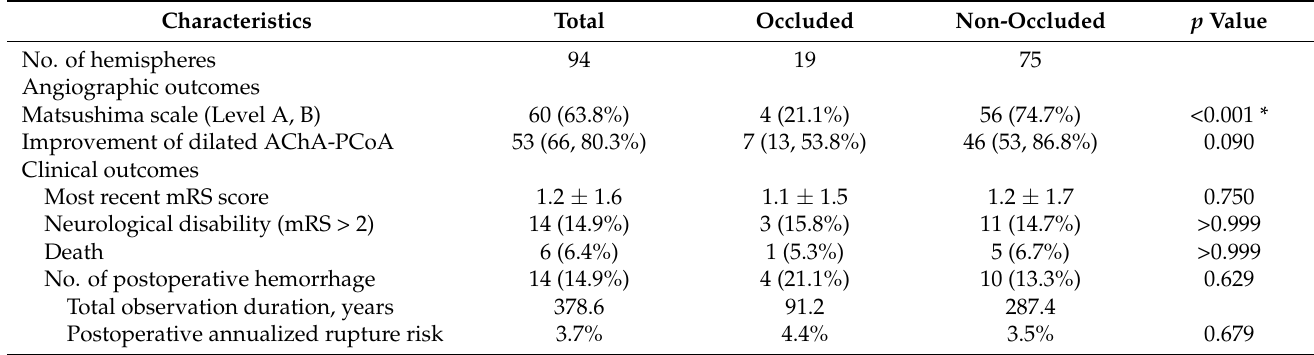
Table 2. Long-term angiographic and clinical